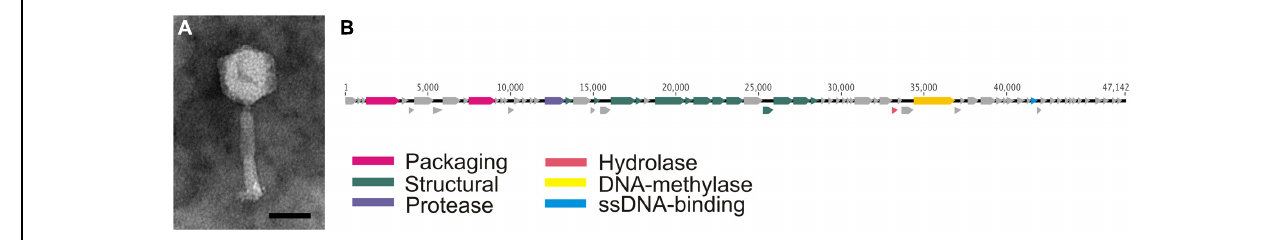
functions included proteins involved in packaging (terminase and phage portal protein; Figure 1 and Supplementary